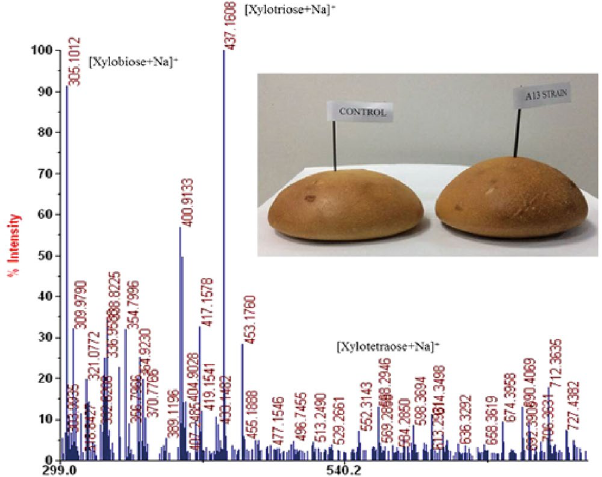
Figure 4. Mass spectrometry analysis of xylan hydrolysate and the whole wheat bread made by recombinant S. cerevisiae A13. The formulation of the dough contained 100 g of whole wheat flour, 20 g of sugar, 1 g of edible salt, 8 g of butter oil, 25 ml of S. cerevisiae A13 liquid culture (10 9 CFU ml − 1 ), and 29 ml of water. The control group was made with S. cerevisiae INV using the same formulation.